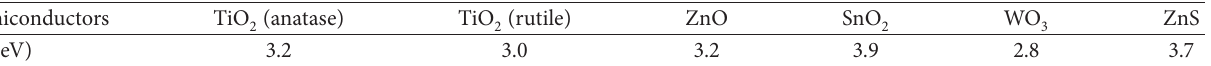
Table 1: Band-gap of some inorganic semiconductors [13, 14].